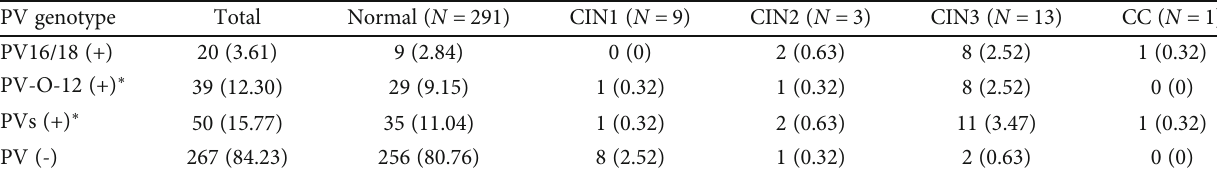
Table 2: HPV distribution with histological diagnoses in women with ASC-US ( n = 317 ). Distribution of HPV in histological diagnoses (%).